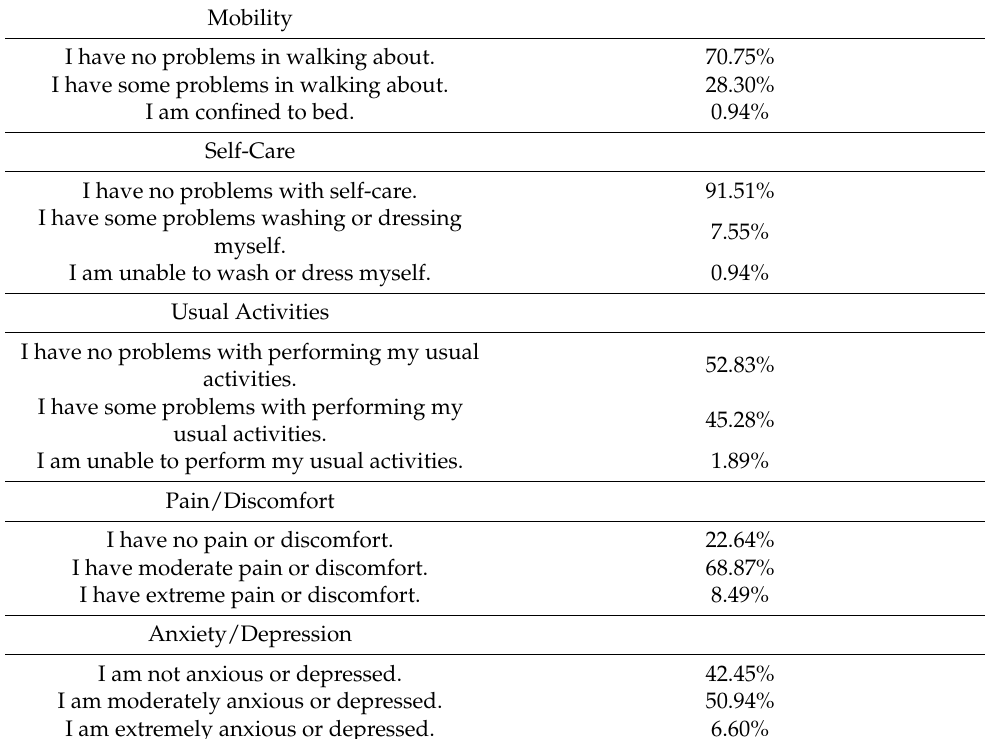
Table 2. Results obtained with the EQ5D questionnaire in our cohort of patients with Fabry disease.